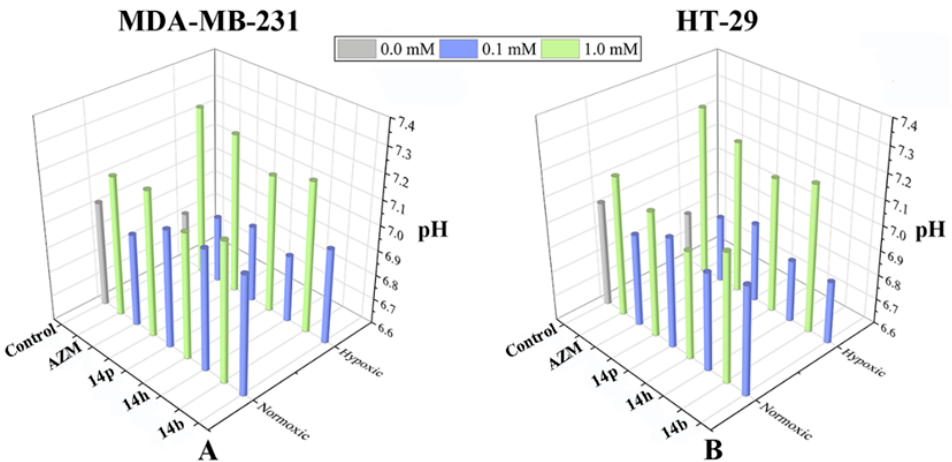
Figure 7. Extracellular pH measurement of MDA-MB-231 ( A ) and HT-29 ( B ) under normoxic and hypoxic conditions.